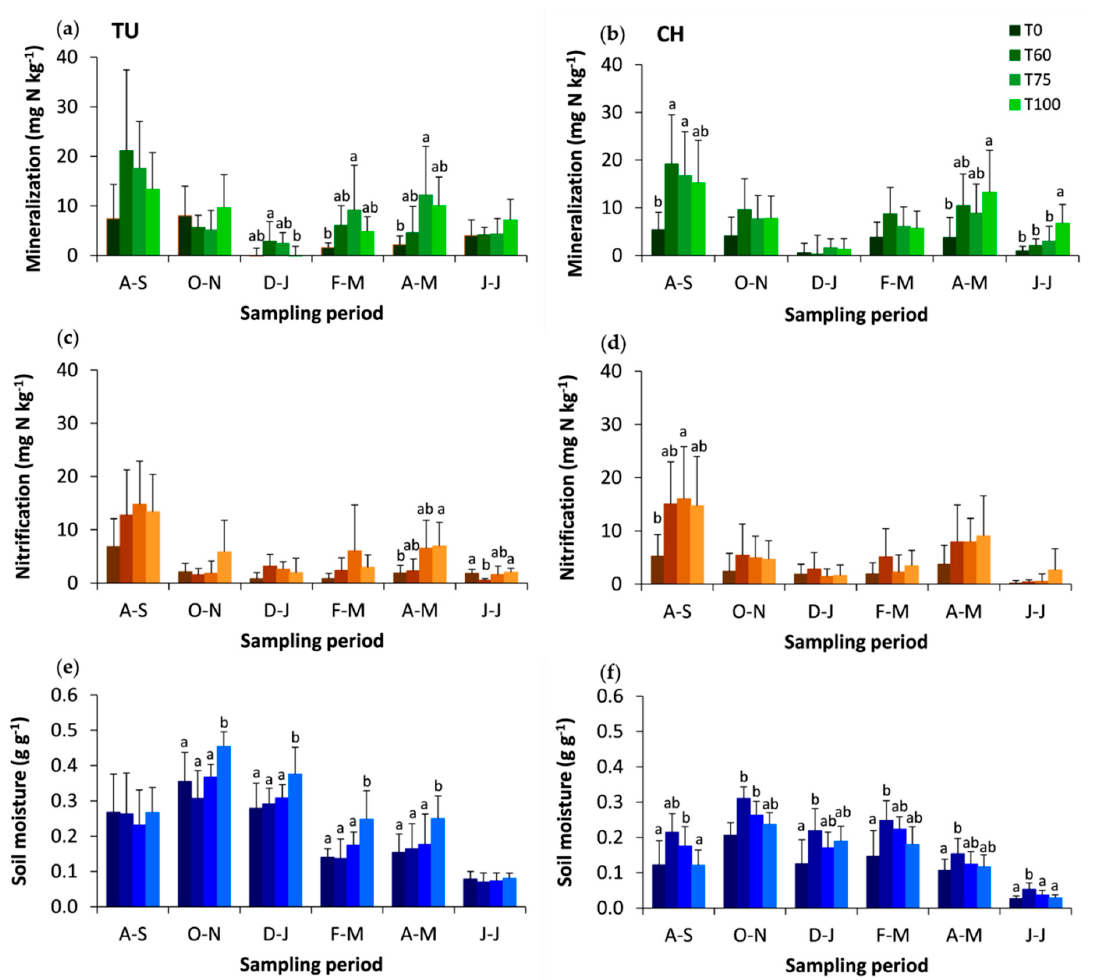
Figure 3. The evolution with time of net N mineralization in Tuéjar ( a ) and Chelva ( b ), net nitrification in Tuéjar ( c ) and Chelva ( d ), as well as soil moisture in Tuéjar ( e ) and Chelva ( f ) in the incubation vessels at the end of the incubation; values for all treatments and blocks. Lower case letters denote significant differences (Tukey’s HSD post hoc test) for the factor silvicultural treatment in each sampling period.